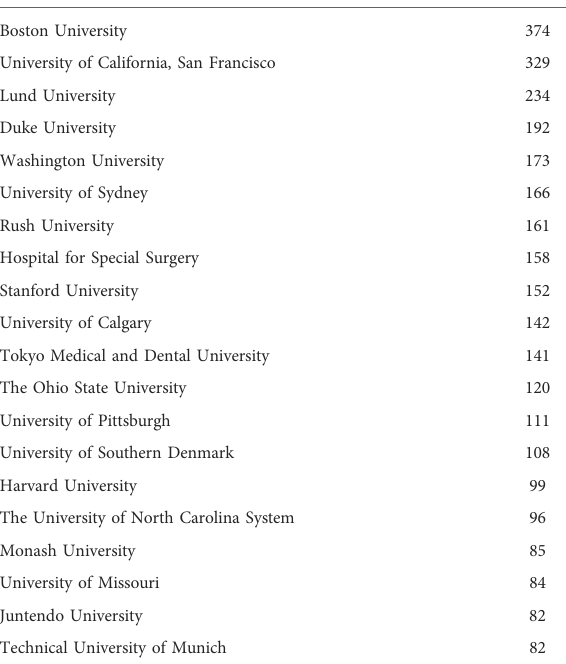
TABLE 5 The article number of the top 20 most high-yielding